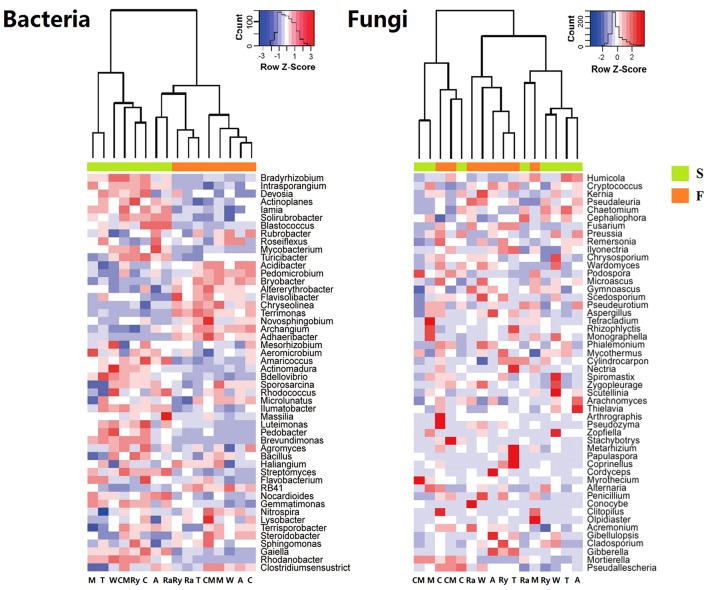
Heatmap of top 50 genera of soil bacterial and fungal communities in the spring (S) and fall (F) cropping seasons. Legends showed the Z-scores, demonstrating all samples were represented by the median-centered Z-scores as the relative abundance levels.